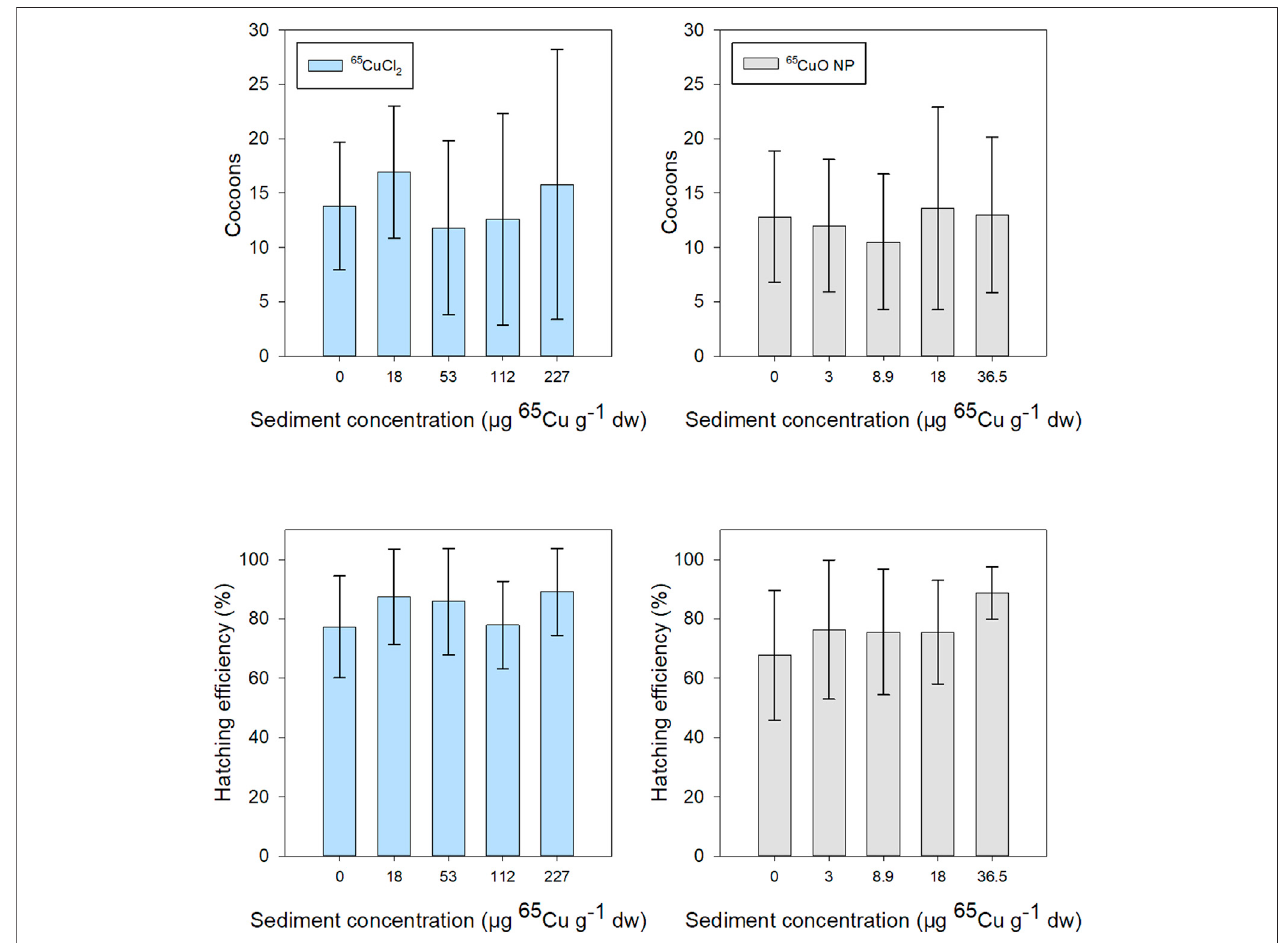
FIGURE 6 | T. tubifex reproduction during exposures in freshly spiked sediment with 65 CuCl 2 (blue) or 65 CuO NPs (gray) at fi ve different concentrations. Reproductiveoutputispresentedasthemean ± SDnumberofcocoonsattheendofexposureandhatchability(numberofcocoonshatched,2.5 monthsafterexposure termination). n (cid:1)